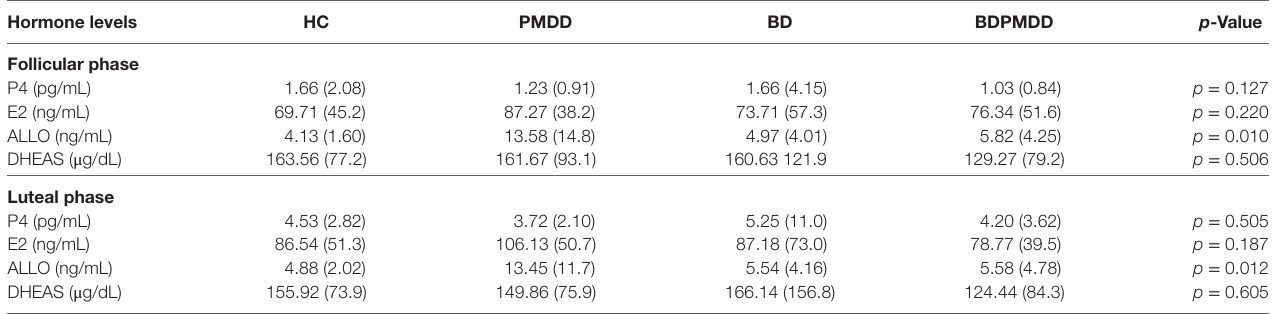
TaBle 3 | Hormone levels in the mid-follicular and late luteal menstrual phases.